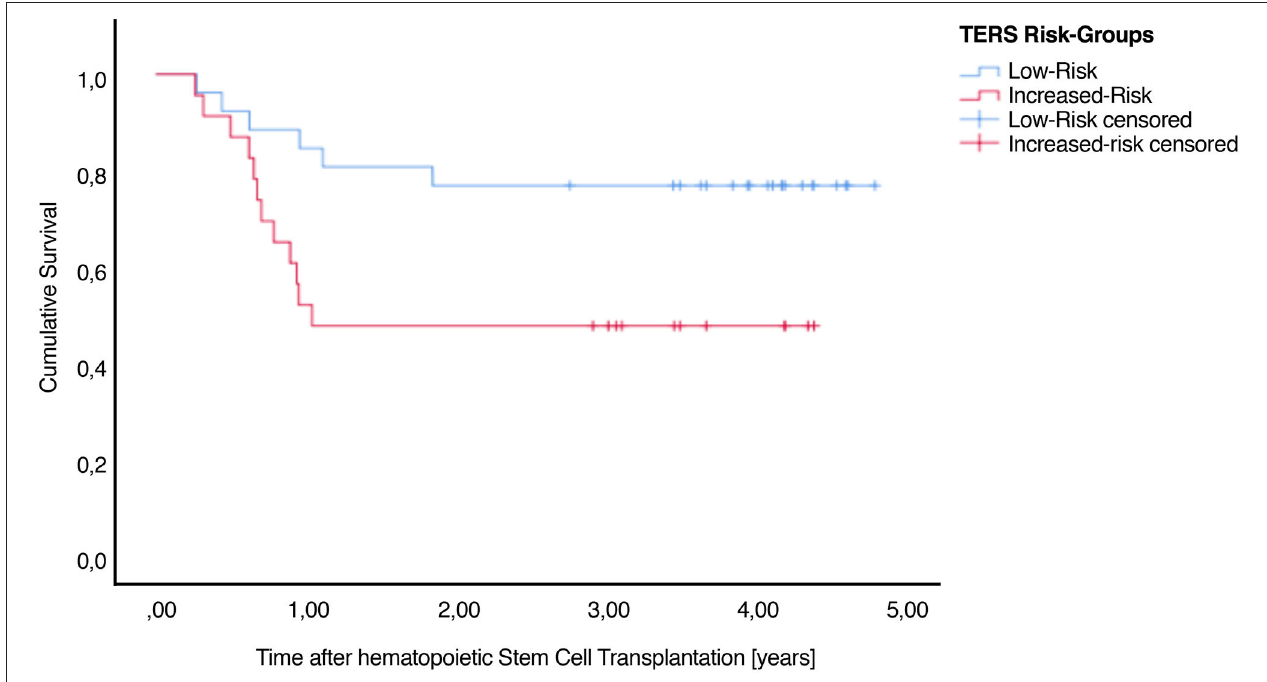
FIGURE 2 | Cumulative survival after HSCT illustrating the association between TERS psychosocial risk scores. There is a significant difference between low-risk and increased-risk patients.